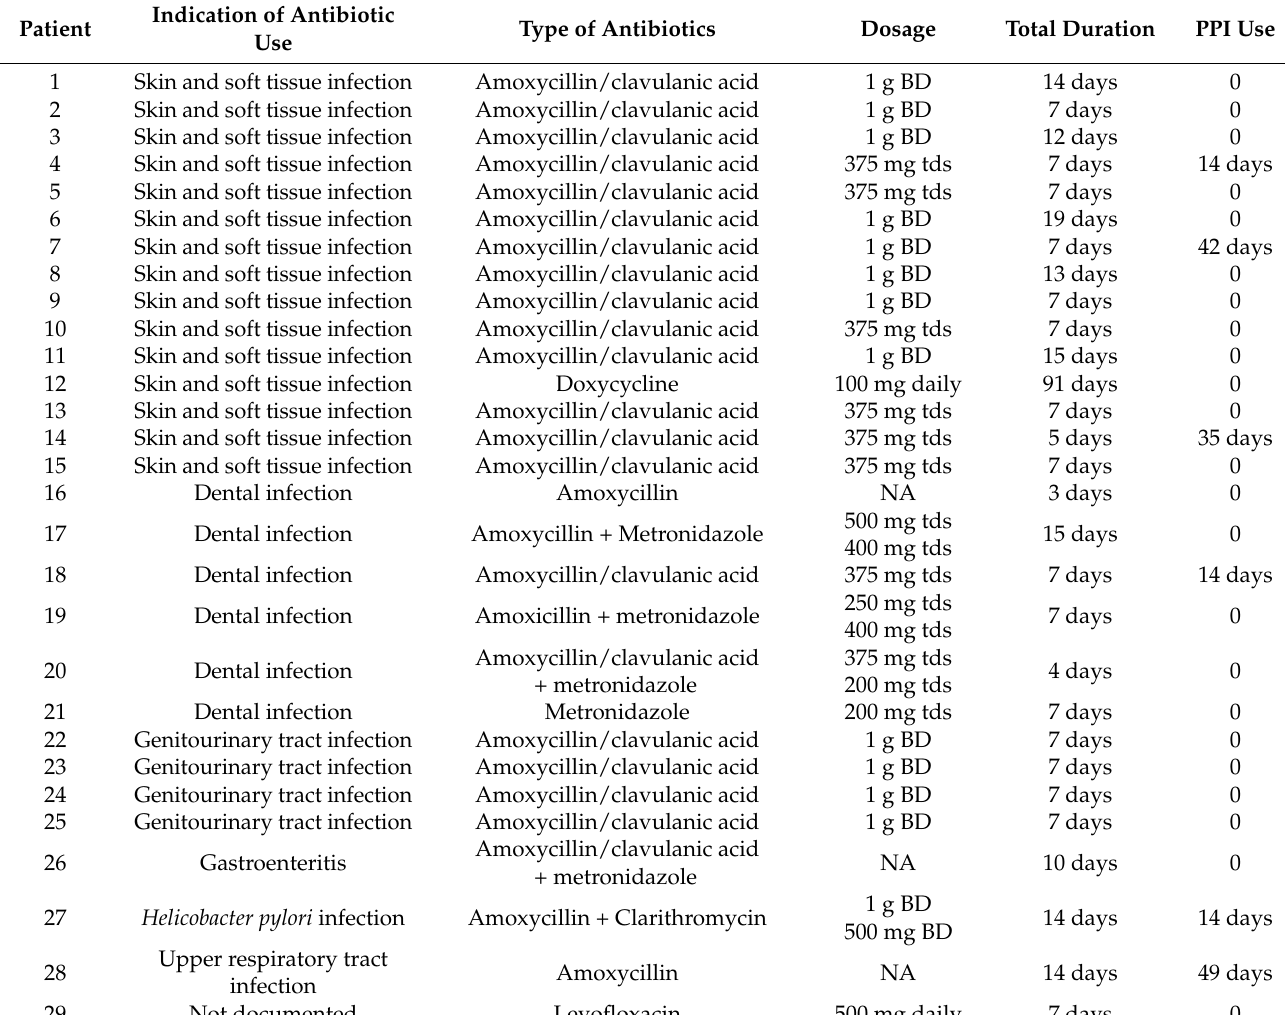
Table 2. Antibiotic use details and concomitant proton pump inhibitor